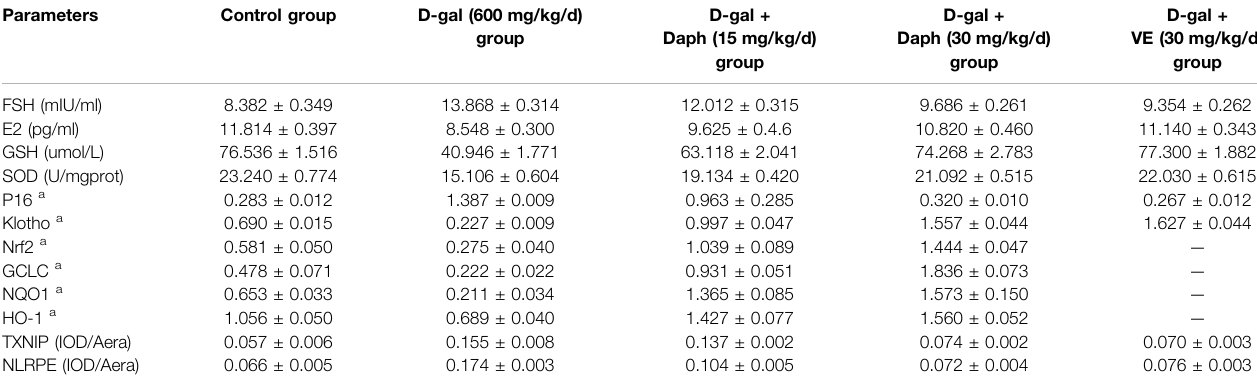
TABLE 1 | Daph ’ effect in WT mice.